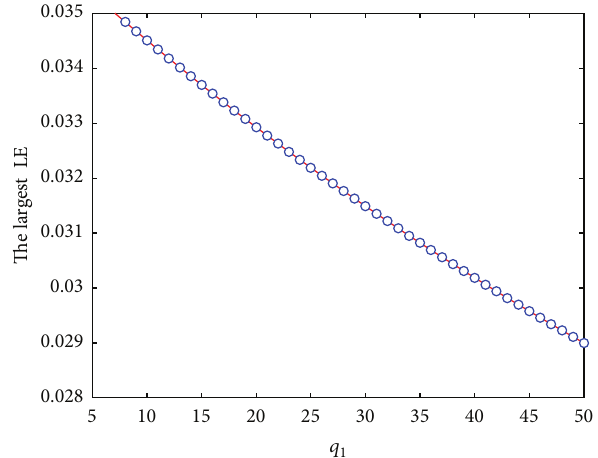
Figure 2: The largest Lyapunov exponent diagram.